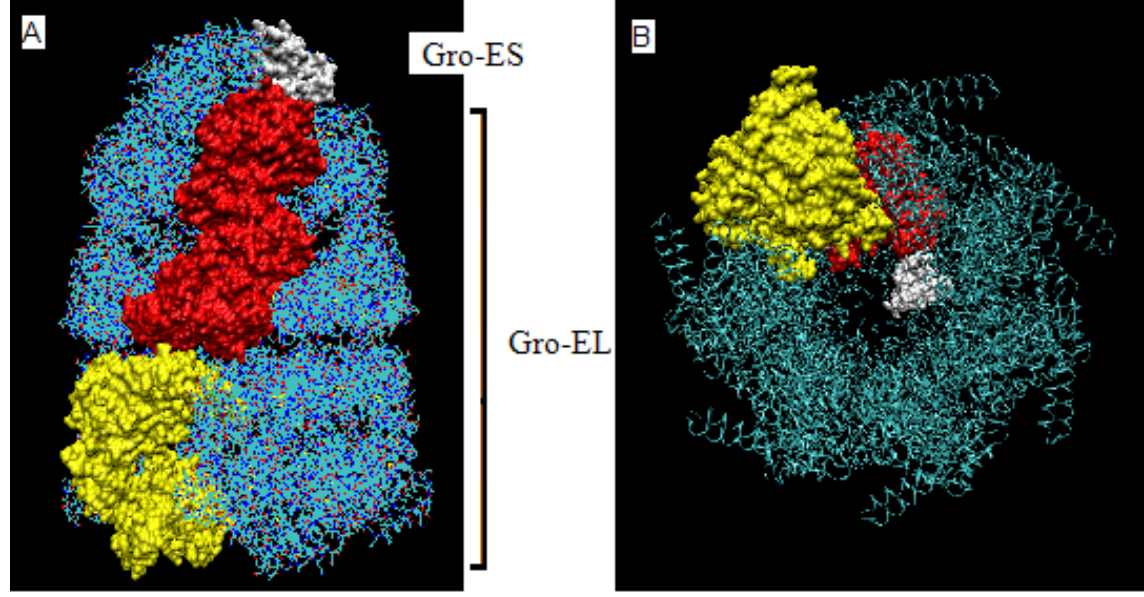
Figure 1. The chaperonin structure. A – Gro-ES (cap) built of the chains O-U – chain O distinguished in white, Gro-EL built of two rings: cis - chains A-G (chain A distinguished in red), trans – chains H-N (chain H in yellow); B – the axial view showing the seven-fold symmetry of the complex. The chains colored as in